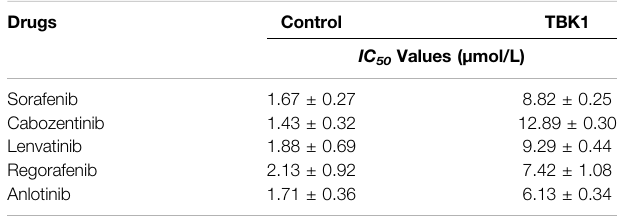
TABLE4| TheeffectofTBK1overexpressiononthesensitivityofMHCC97-Lcells to molecular-target drugs, Sorafenib, Cabozentinib, Lenvatinib, Regorafenib or Anlotinib.